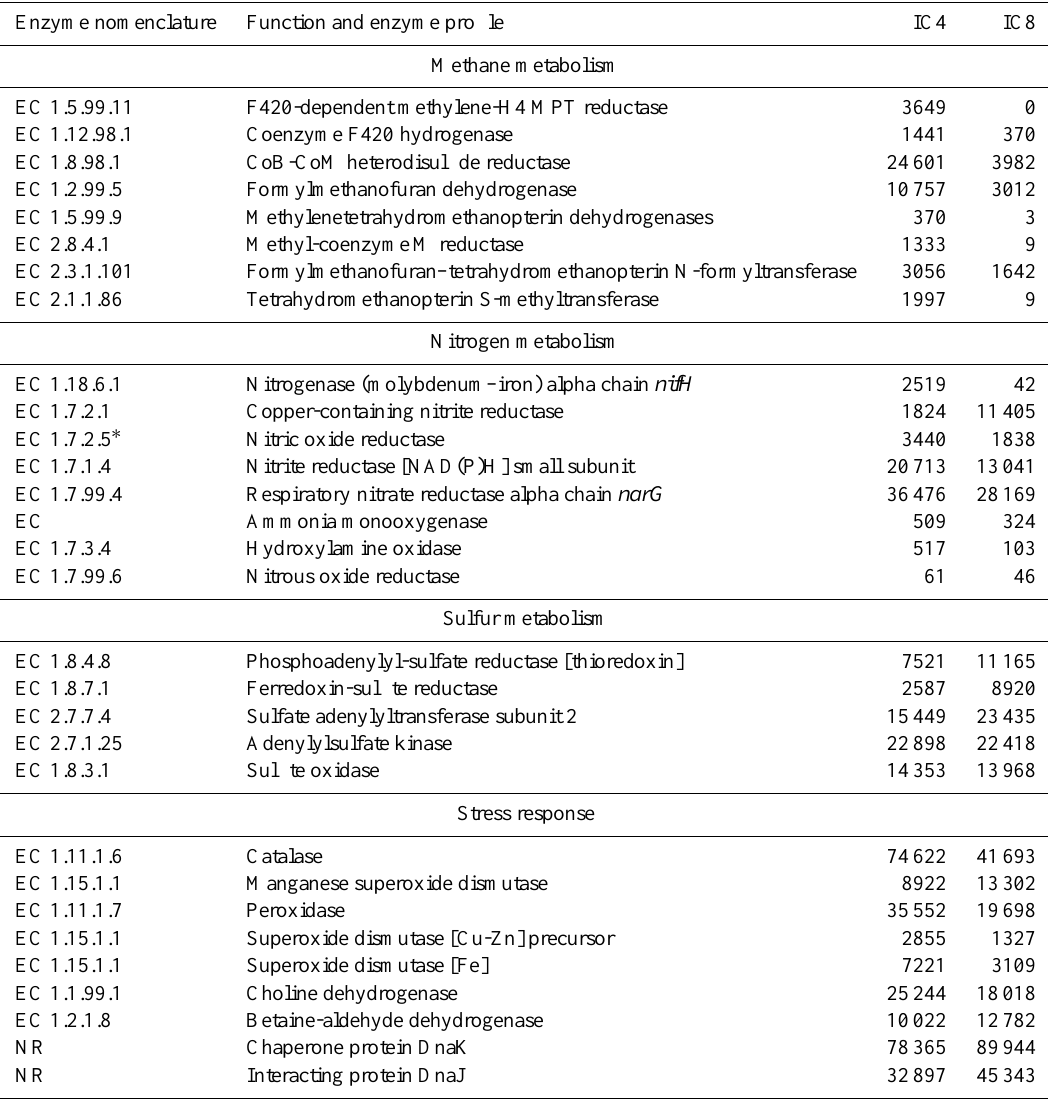
Table 2. Number of sequences showing homologies to genes associated with KEGG pathways within the IC4 and IC8 metagenomes. Data were generated by searching in hierarchical classification table based upon SubSystems annotation